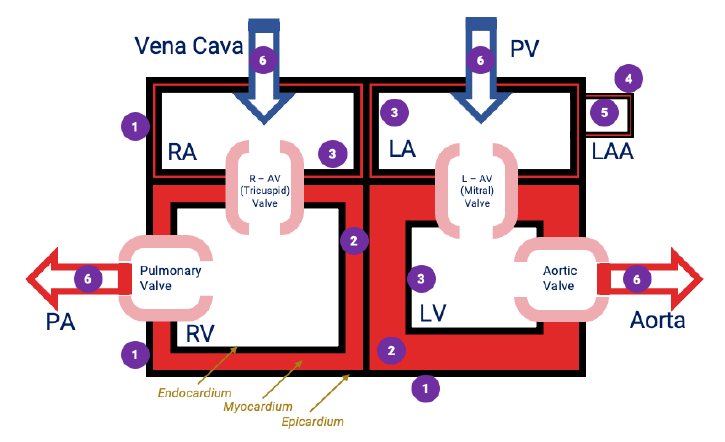
Figure 3. Schematic of measurement locations. n = 17 distinct locations were selected with 15 measurements at each location. These locations were divided into 6 groups as (1) epicardium; (2) endocardium, (3) endocardium, (4) the exterior surface of the atrial appendage, (5) the interior surface of the atrial appendage and (6) luminal surface of the great vessels. These groupings 1–6 are shown in the figure. (RA = right atrium, LA = left atrium, RV = right ventricle, LV = left ventricle, R–AV Valve = right atrioventricular valve, L–AV Valve = left atrioventricular valve, PA = pulmonary artery, PV = pulmonary vein, LAA = left atrial